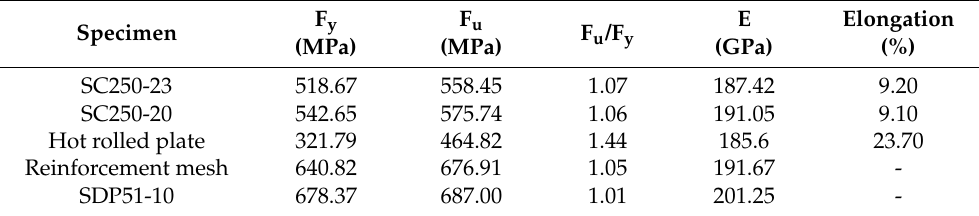
Reinforcement Table 1. Materials Properties.